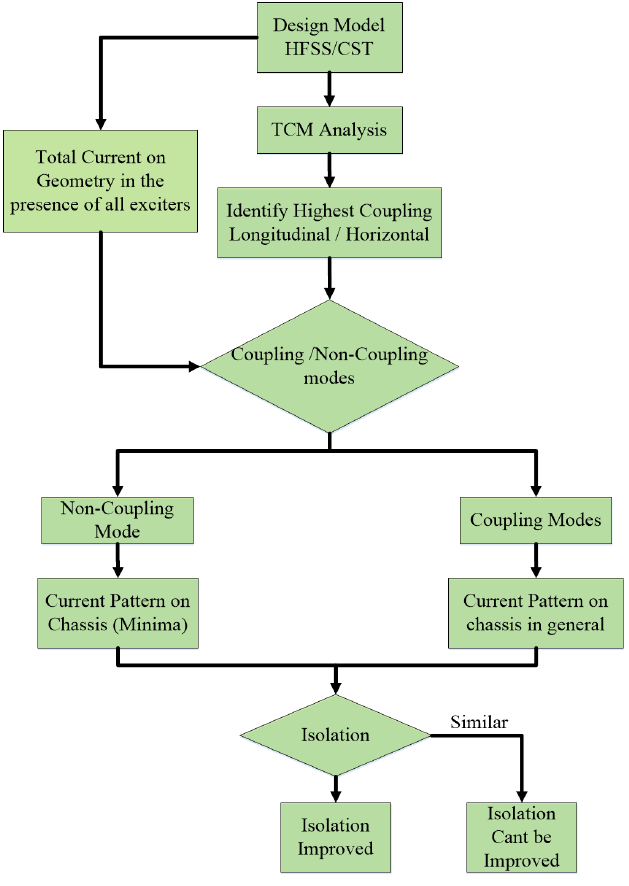
Figure 1. Block diagram of proposed isolation enhancement scheme that can predict whether the isolation can be enhanced or not